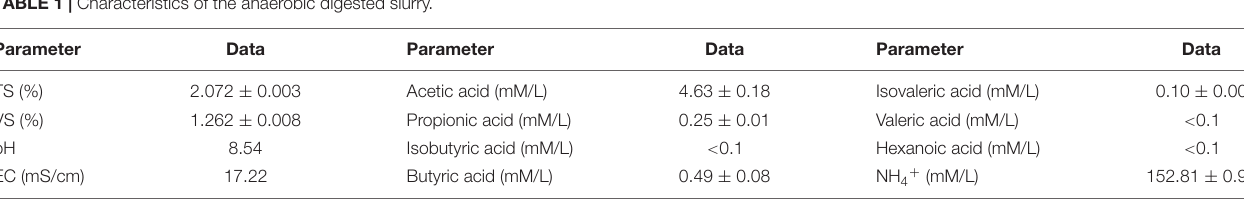
FIGURE 4 | Current density variation along with time corresponding to different VFAs (A) and accumulated VFAs at a reaction time of 5 h in anode chamber with different initially added VFAs in the sample chamber (B) . TABLE 1 | Characteristics of the anaerobic digested